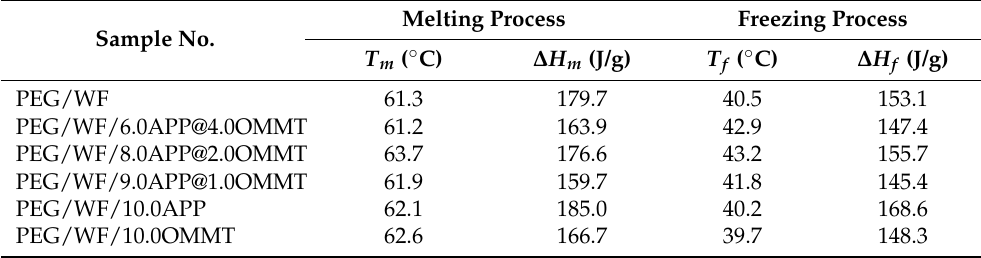
Table 3. Thermal energy storage characteristics of di ff erent composites in the present study.